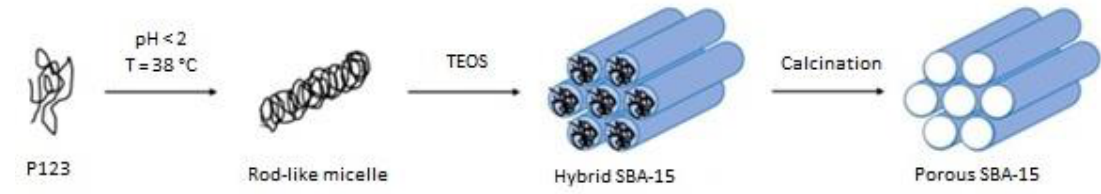
Figure 1. Synthesis of mesoporous silica (SBA-15) [14].